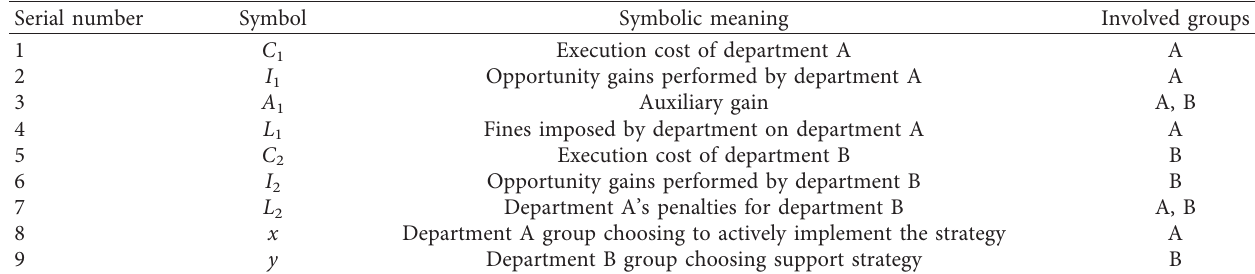
Table 1: Partial patient information.